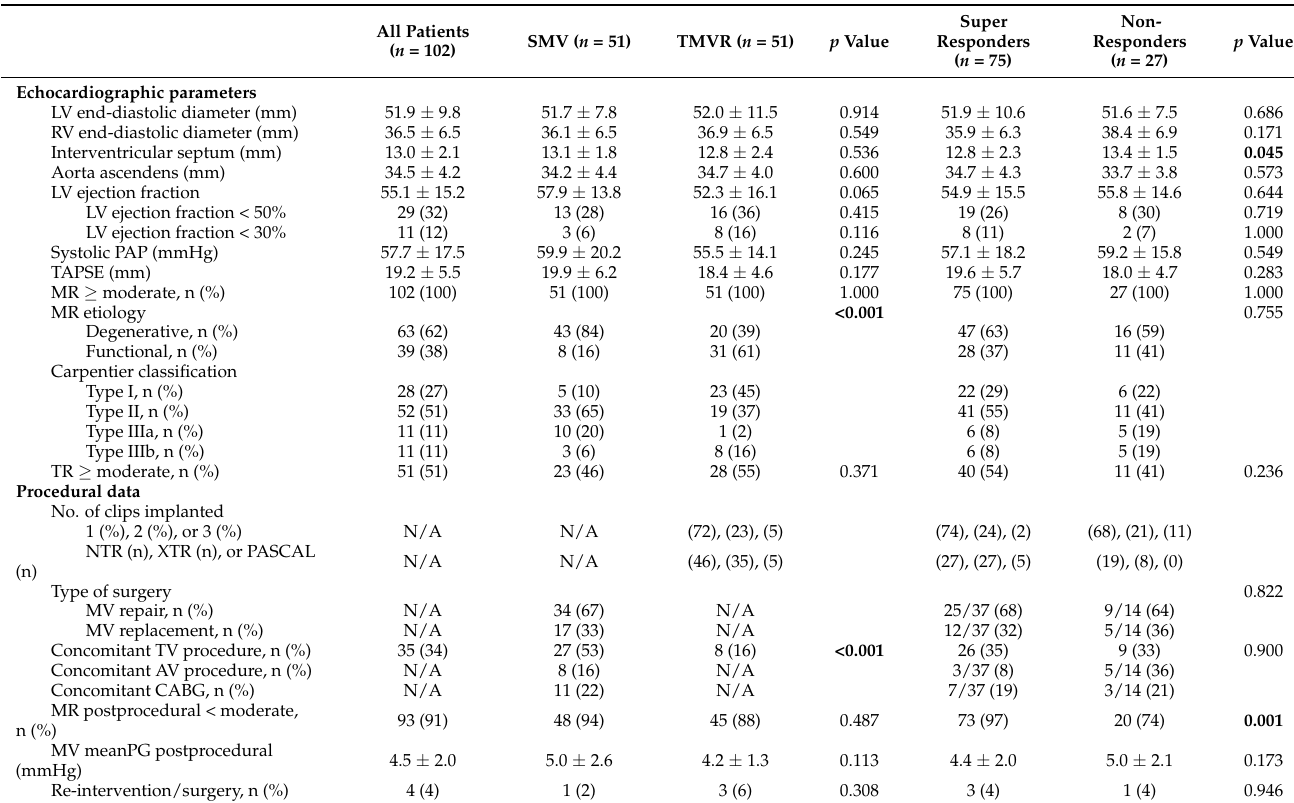
Table 2. Baseline imaging and procedural data of the matched study population and stratified for “Super Responders” vs.